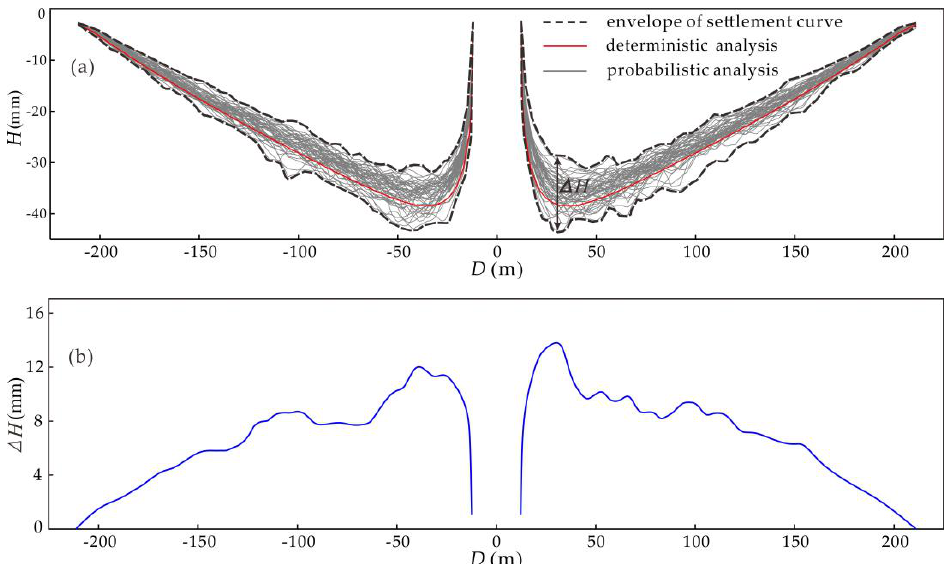
the curtain (in the black dashed line) with the deterministic settlement curve (in the red dashed line) indicated that it has an insignificant difference outside D 2 , but a significant difference within the range.